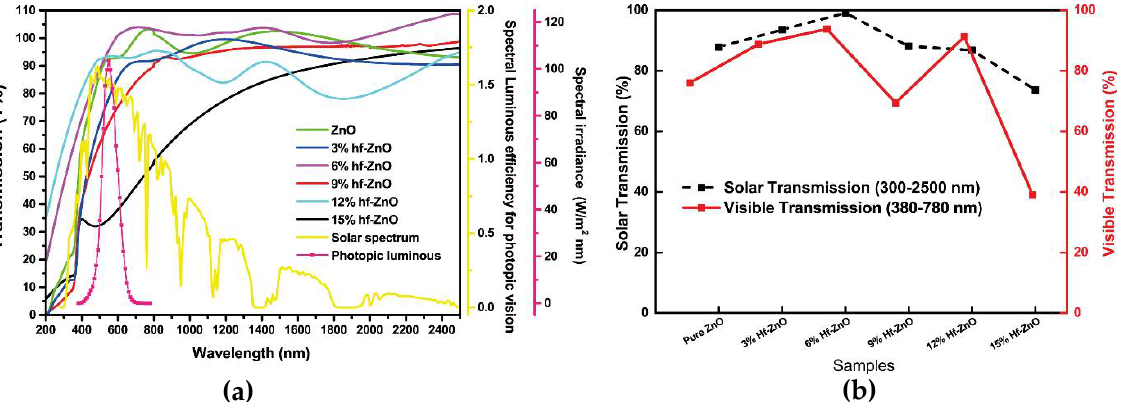
Figure 3. ( a ) Wavelength-dependent UV, visible and NIR transmission spectra of pure and Hf-doped ZnO thin films. ( b ) Relation between solar and visible transmission for ZnO with various levels of Hf doping.